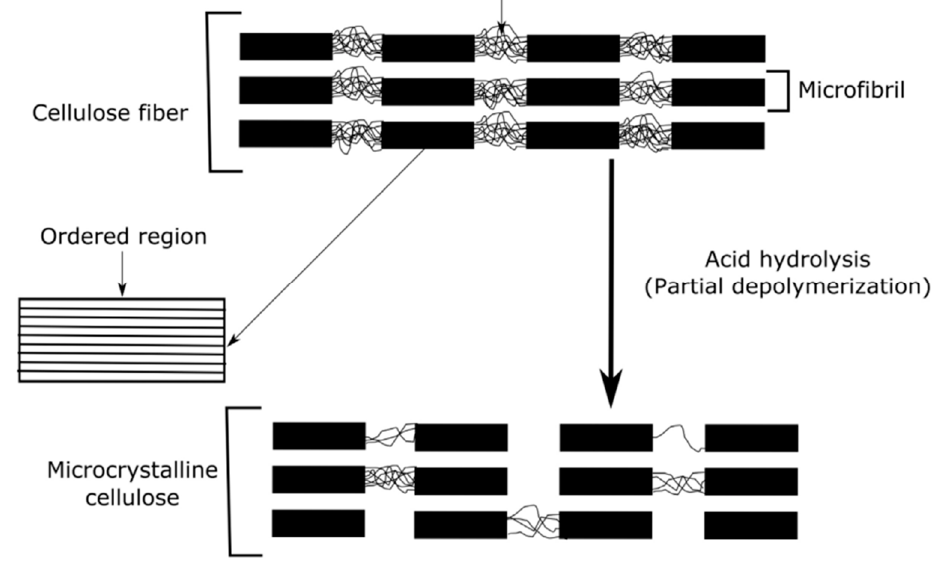
Figure 8. Schematic illustration of the microcrystalline cellulose separation during acid hydrolysis (reproduced with permission from [91]).